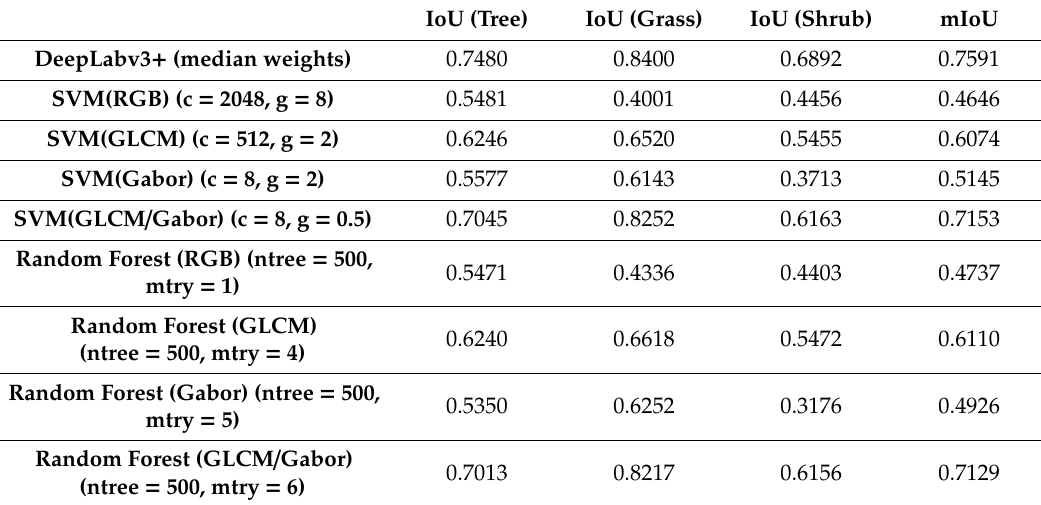
Table 25. IoU and mIoU values for sampled pixels investigation in Oregon